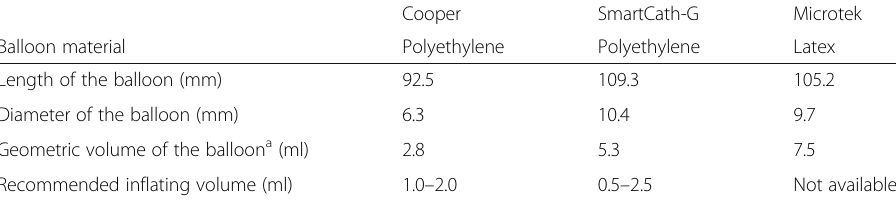
Table 1 Balloon material and dimension